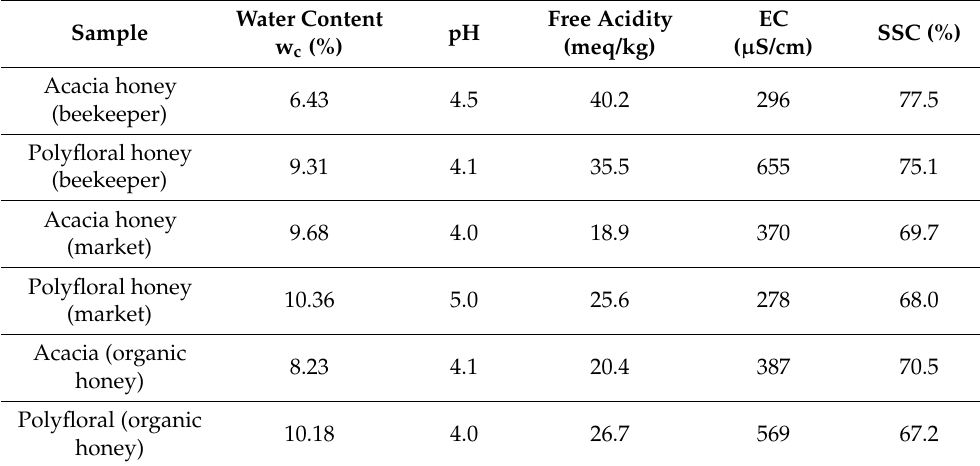
Table 3. The water content, pH, acidity and electrical conductivity (EC) of the analyzed honey samples ( n = 3).